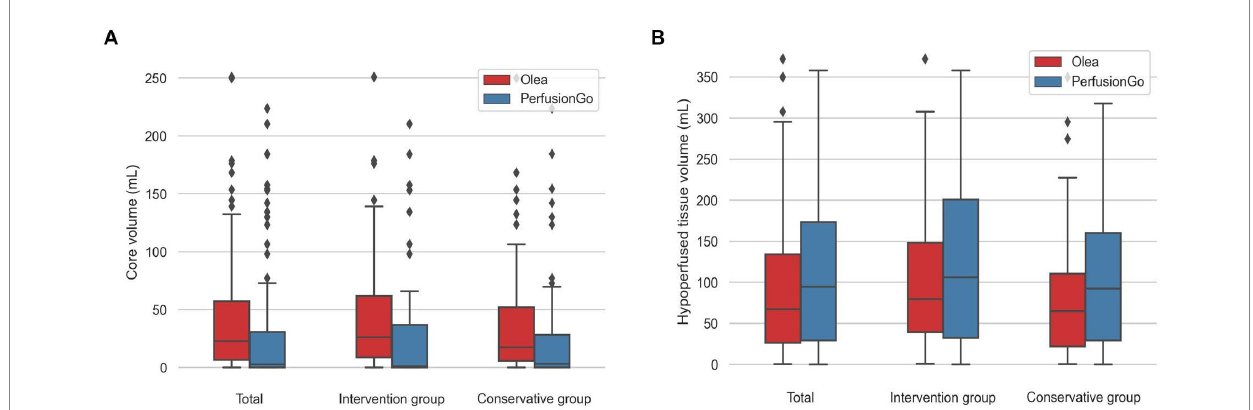
FIGURE 2 Boxplots of core and hypoperfusion volume estimated by Olea and PerfusionGo software. Bars indicate the range of core and hypoperfusion volume. Boxes represent values within the 25–75th percentiles [interquartile range (IQR)], and horizontal lines represent the median. (A) core volume. (B) hypoperfusion volume.